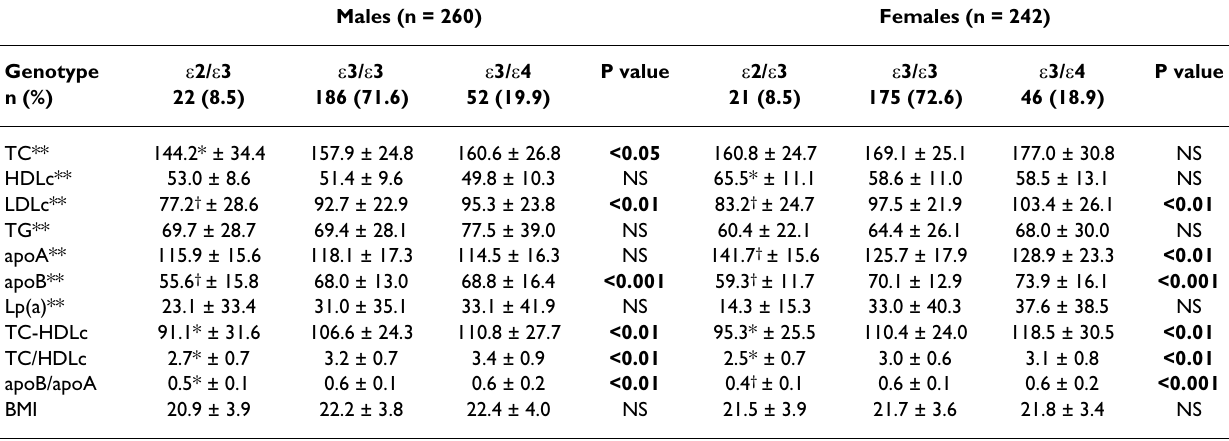
Table 3: Lipid and lipoprotein levels (mg/dl), and body mass index (kg/m 2 ) according to the APOE genotypes and sex Males (n = 260) Females (n = 242) Genotype